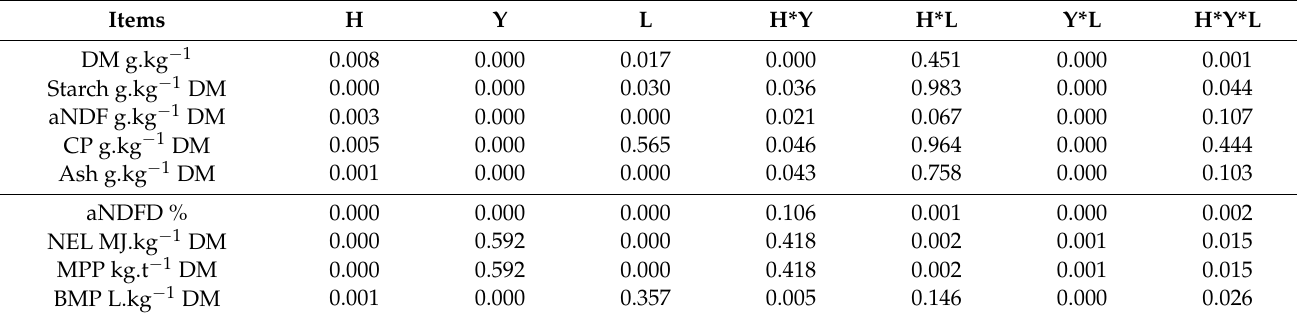
Table 4. Statistical significance by hybrid (H), year (Y), location (L) and their interactions